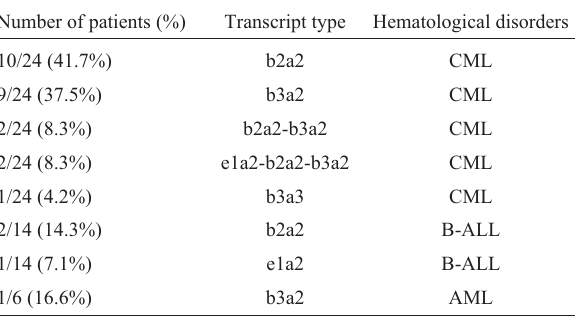
Table 1 - Types of bcr-abl transcripts in clinical